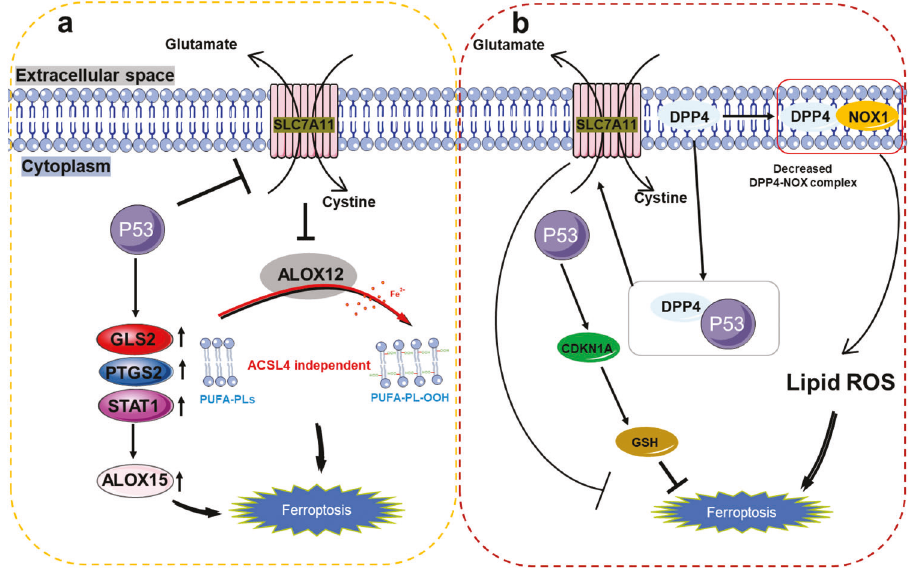
Fig. 4 The various roles of p53 in ferroptosis. a P53 can further promote the upregulation of ALOX15 by promoting the expression of GLS2, PTGS2, and STAT1, and ultimately promote ferroptosis, or p53 can indirectly activate the function of ALOX12 by inhibiting the transcription of SLC7A11, leading to ALOX12-dependent ferroptosis after ROS stress, this pathway mediated by ALOX12 and independent of ACSL4, promotes the peroxidation of polyunsaturated fatty acid-containing phospholipids (PUFA-PLS). b P53 can also inhibit the generation of cellular lipid- reactive oxygen species by competitively binding to DPP4 with NOX1; at the same time, the P53-DPP4 complex promotes the expression of SLC7A11 and CDKN1A to inhibit